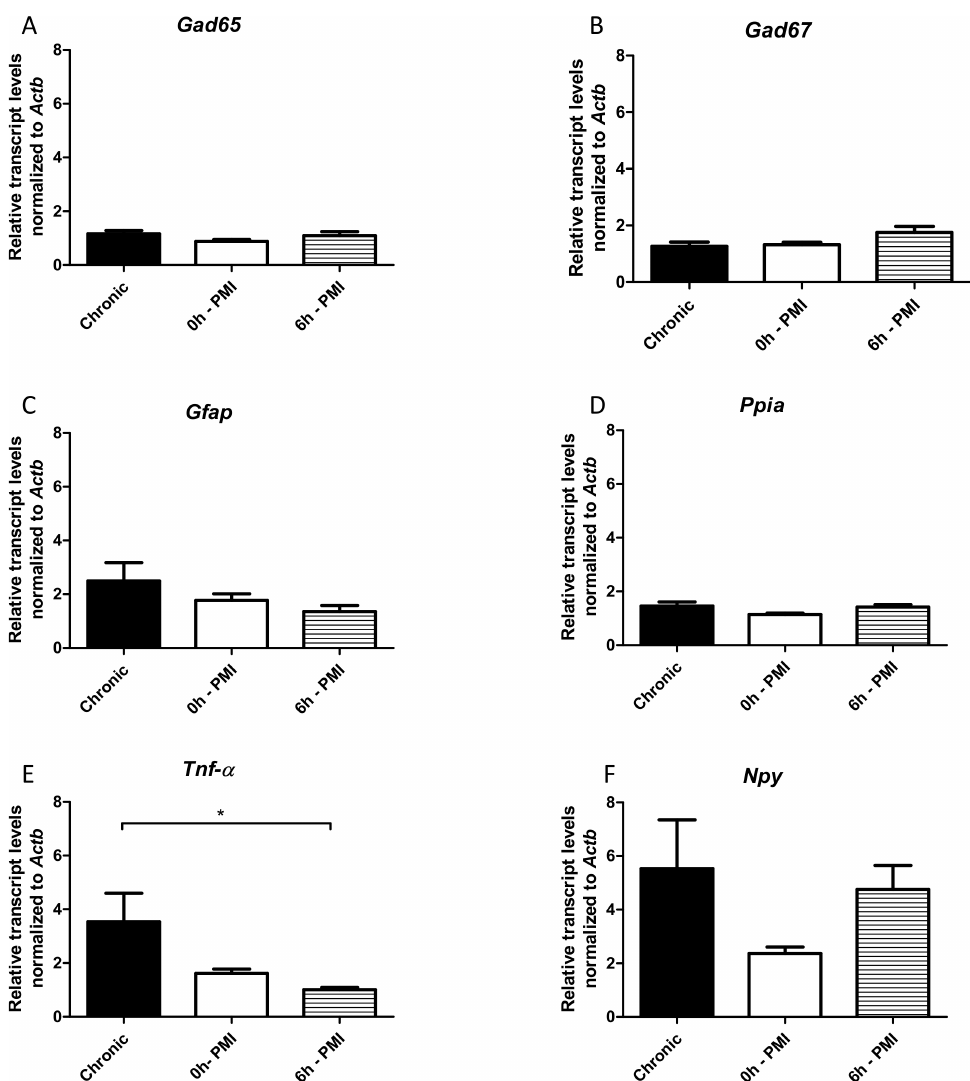
Fig 4. Hippocampal relative expression of Gad65 , Gad67 , Gfap , Tnf- α , Npy and Ppia genes in chronic group compared with 0h and 6h postmortem intervals. Values are mean ± SEM, n = 6, ANOVA with Bonferroni post hoc, * p <